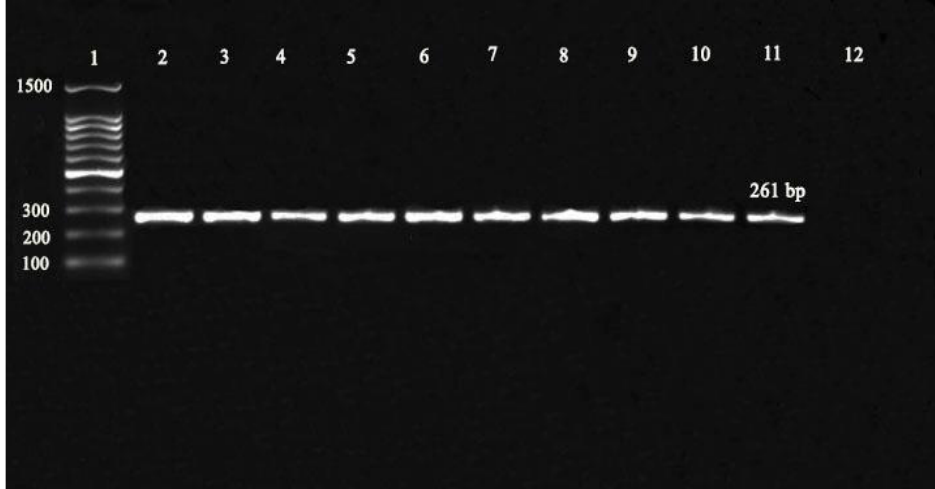
Figure 2. Gel image of the PCR product of HAdV. Lane 1, DNA marker (100–1500 bp); lane 12,